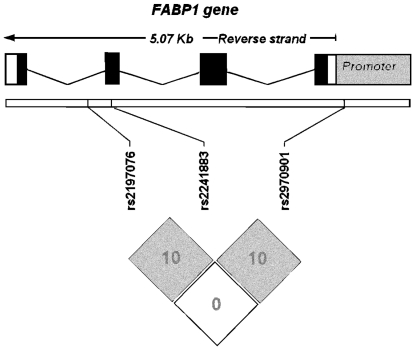
Linkage disequilibrium of the associated region of FABP1 using the R-square color scheme.